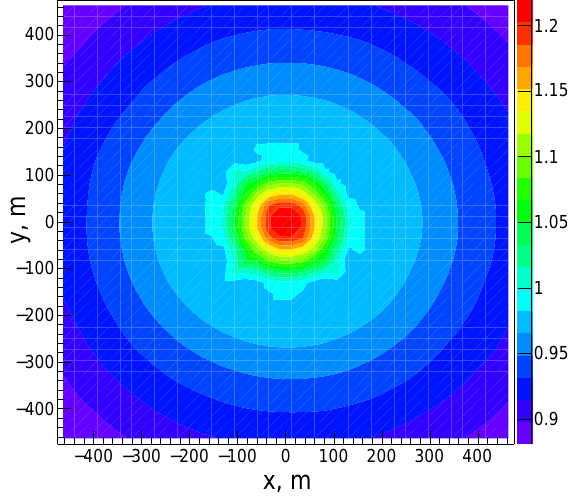
Figure 19. The ratio of sample averaged Cherenkov photons distribution for the CORSIKA atmo- sphere model pair 11/4. Bin size 50 m × 50 m. Primary protons with 10 PeV energy. Zenith angle 15 ◦ . Sample volume 30 events.